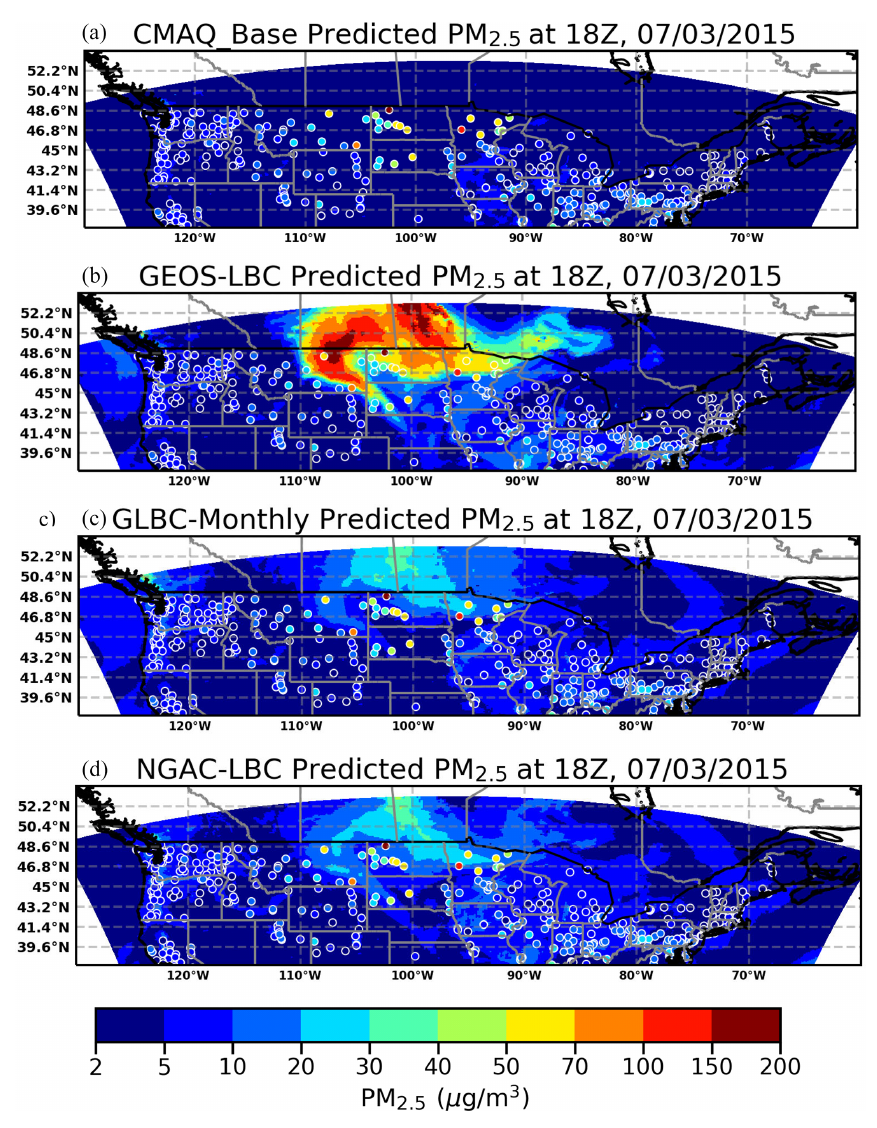
Figure 8. Same as Fig. 4 but for the northern USA on 3 July 2015. Please note that the dates in this figure are given in the format of month day year (mm/dd/yyyy). This figure is plotted using cartopy https://scitools.org.uk/cartopy/docs/latest/ (last access: February 2021), which uses the national and state border information from http://www.naturalearthdata.com/ (last access: February 2021). Please note that the above figure contains incomplete US state